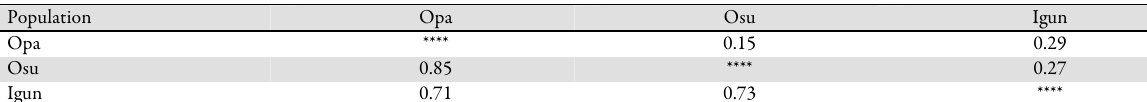
Table 4. Pair wise comparison of Nei’s genetic identity of the three populations of T. zillii studied with genetic distance (below diagonal) and index of similarity (above diagonal)